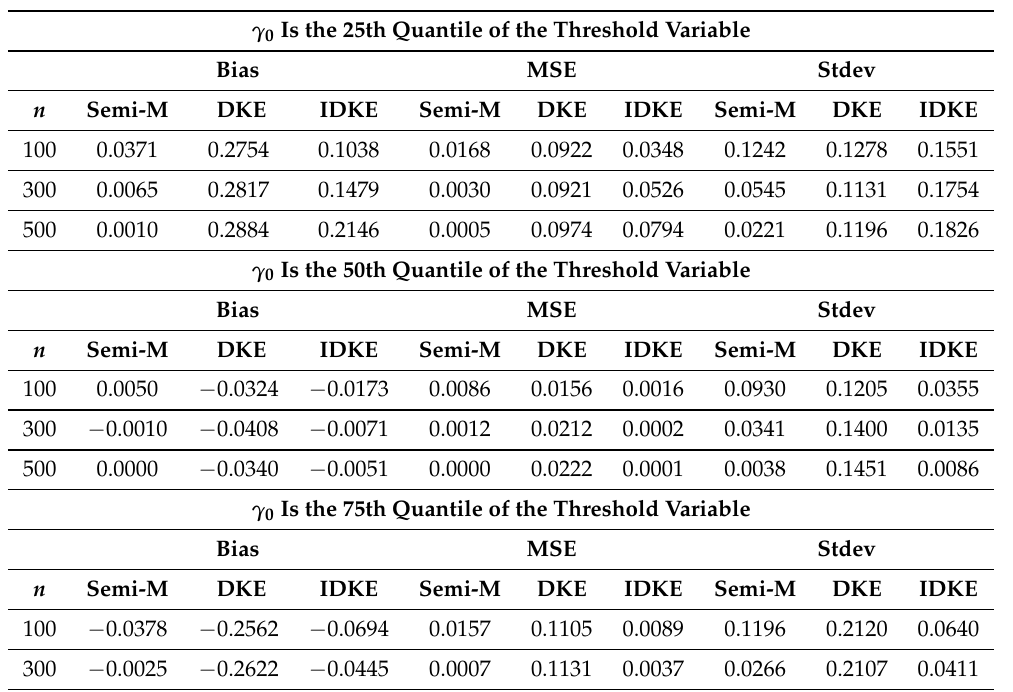
Table 4. Simulation results of nonparametric threshold estimators, DGP 4.